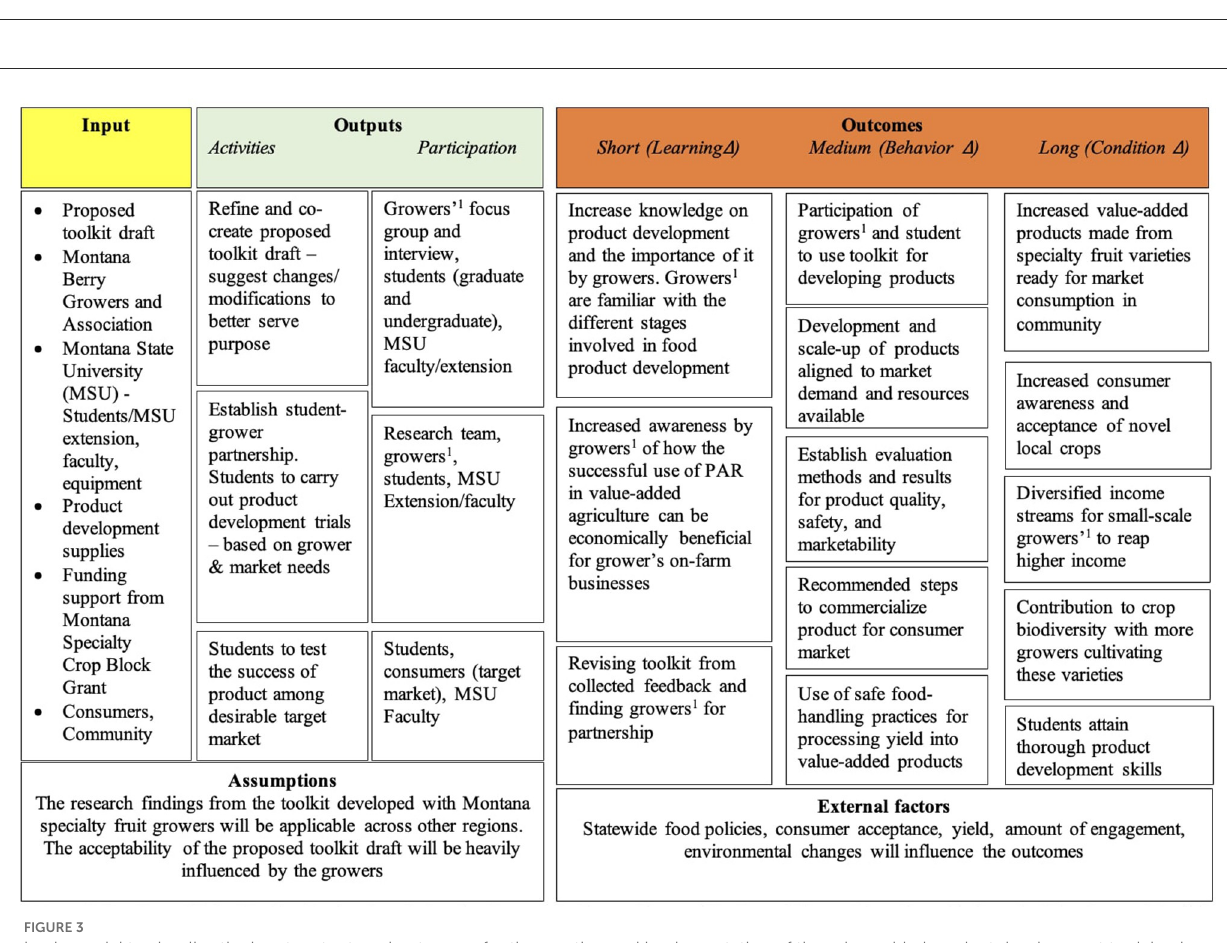
FIGURE3 Logic model to visualize the input, output, and outcomes for the creation and implementation of the value-added product development tool. Logic model is based on the approach demonstrated by Taylor-Powell and Henert (2018). 1 In this model, any place where it is mentioned growwers, it signifies Montana specialty fruit